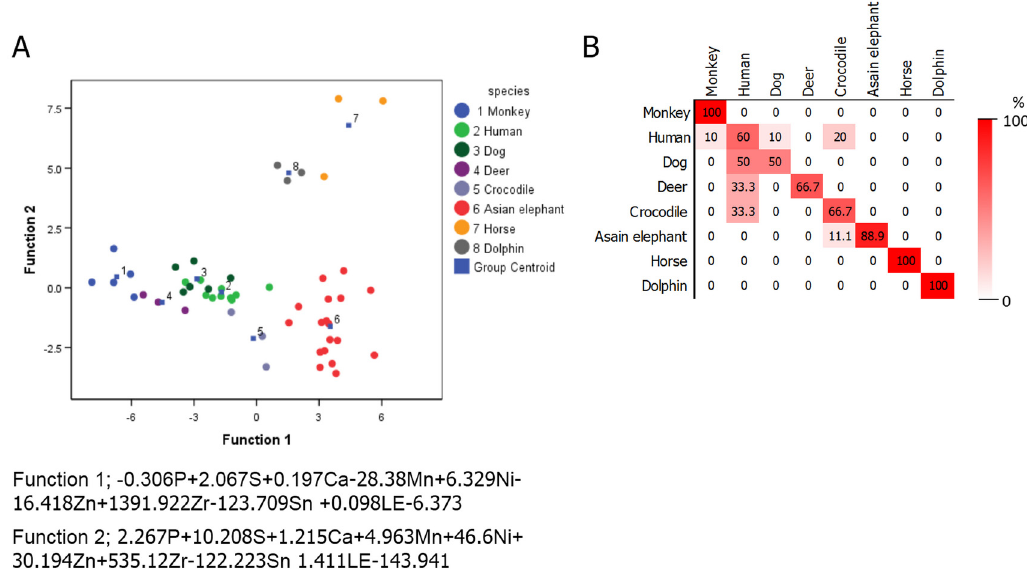
Fig 3. Differentiation of human and others from elemental composition in mineralized tissues. Canconical discriminant plots of the elemental composition of human, monkey and non-primate (dog, Asian elephant, horse and spinner dolphins) teeth (A) and humerus bone